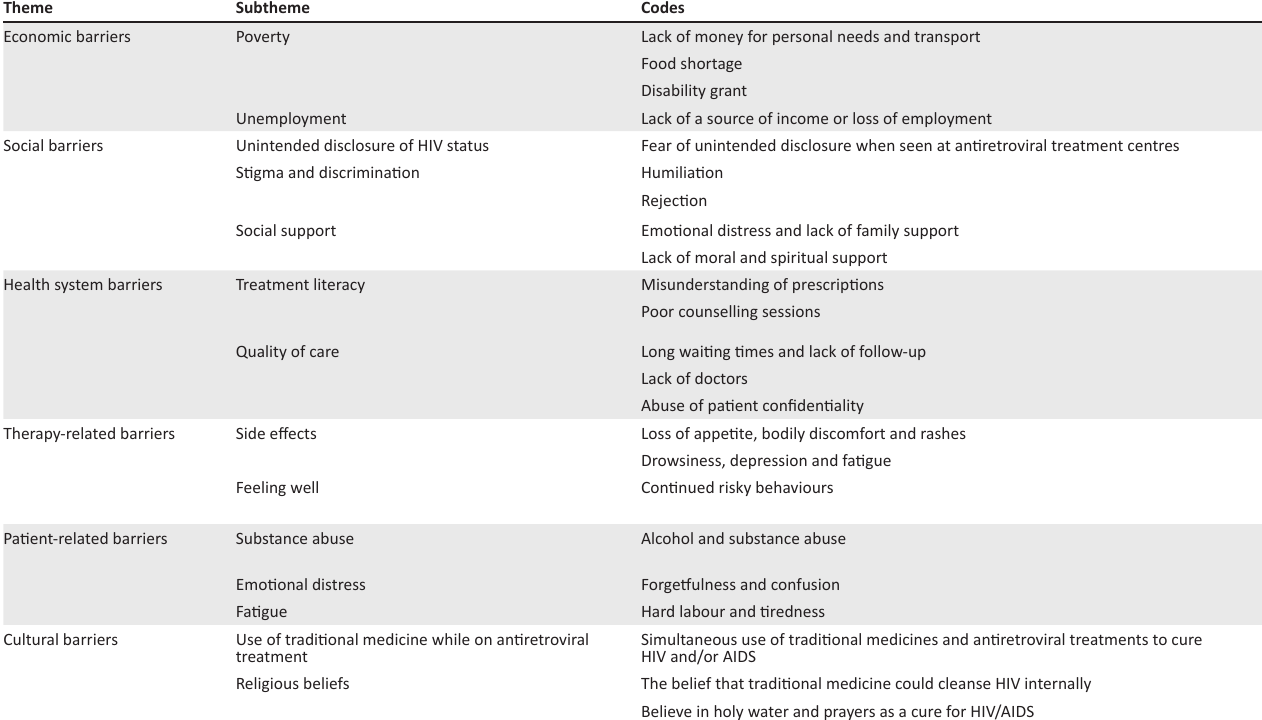
TABLE 2: Themes, subcodes and codes obtained from the data analysis.